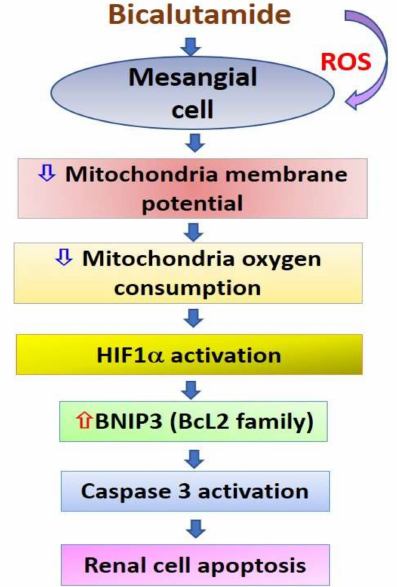
Figure 8. A graphic summary of bicalutamide-induced renal mesangial cell damage via mitochondrial